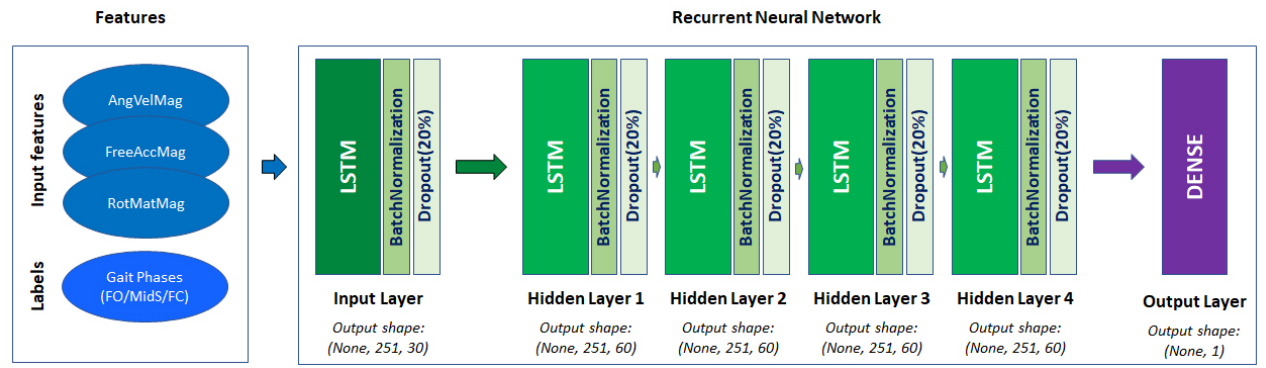
Figure 5. The structure of the Recurrent Neural Network.